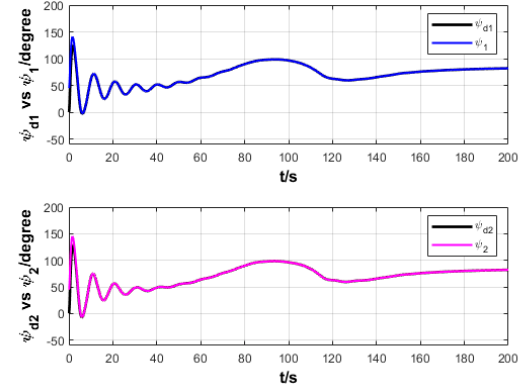
Figure 14. Heading angle variation of USV under two strategies.